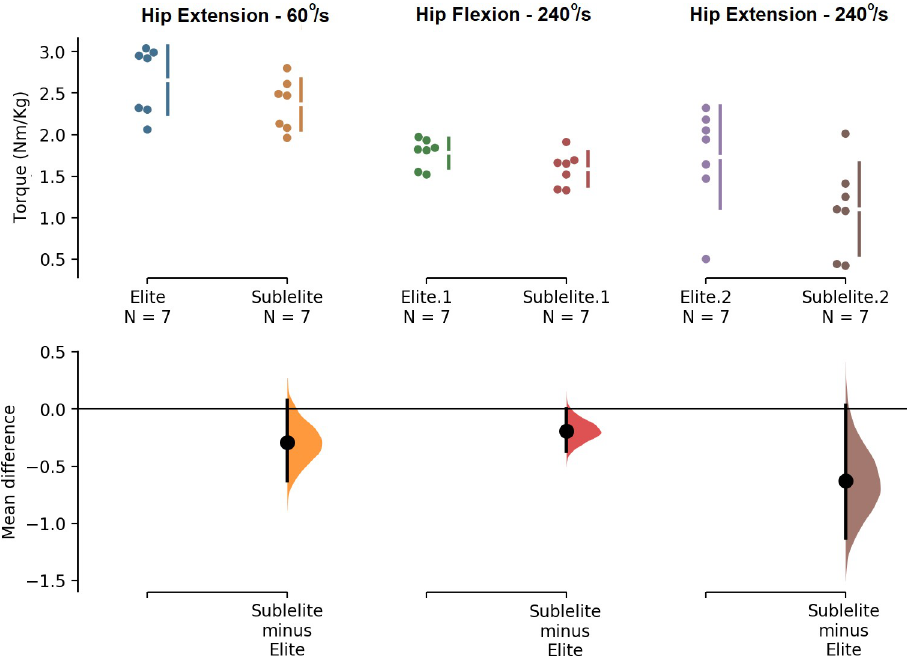
Fig 3. Comparisons for the most statistically significant torque variables. The mean difference for 3 comparisons are shown in the above Cumming estimation plot. The raw data is plotted on the upper axes; each mean difference is plotted on the lower axes as a bootstrap sampling distribution. Mean differences are depicted as dots; 95% confidence intervals are indicated by the ends of the vertical error bars